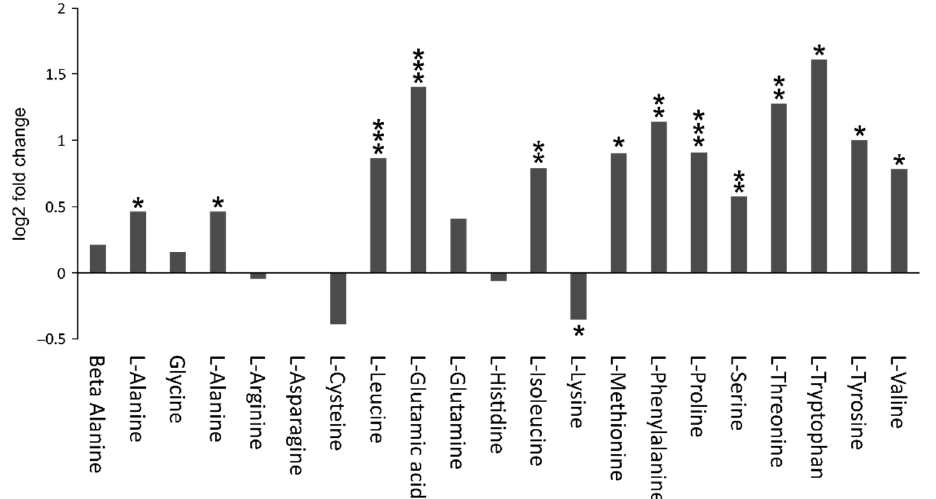
Figure 4. Several amino acids show clearly different levels in the Mecp2 − /y and WT cortex. The ma- jority were detected at higher levels in Mecp2 − /y mice. Only lysine was decreased compared to WT conditions. Plotted are the log2 fold changes of the respective compounds. Asterisks indicate signif- icant changes compared to WT (* p < 0.05, ** p < 0.01, *** p < 0.001).